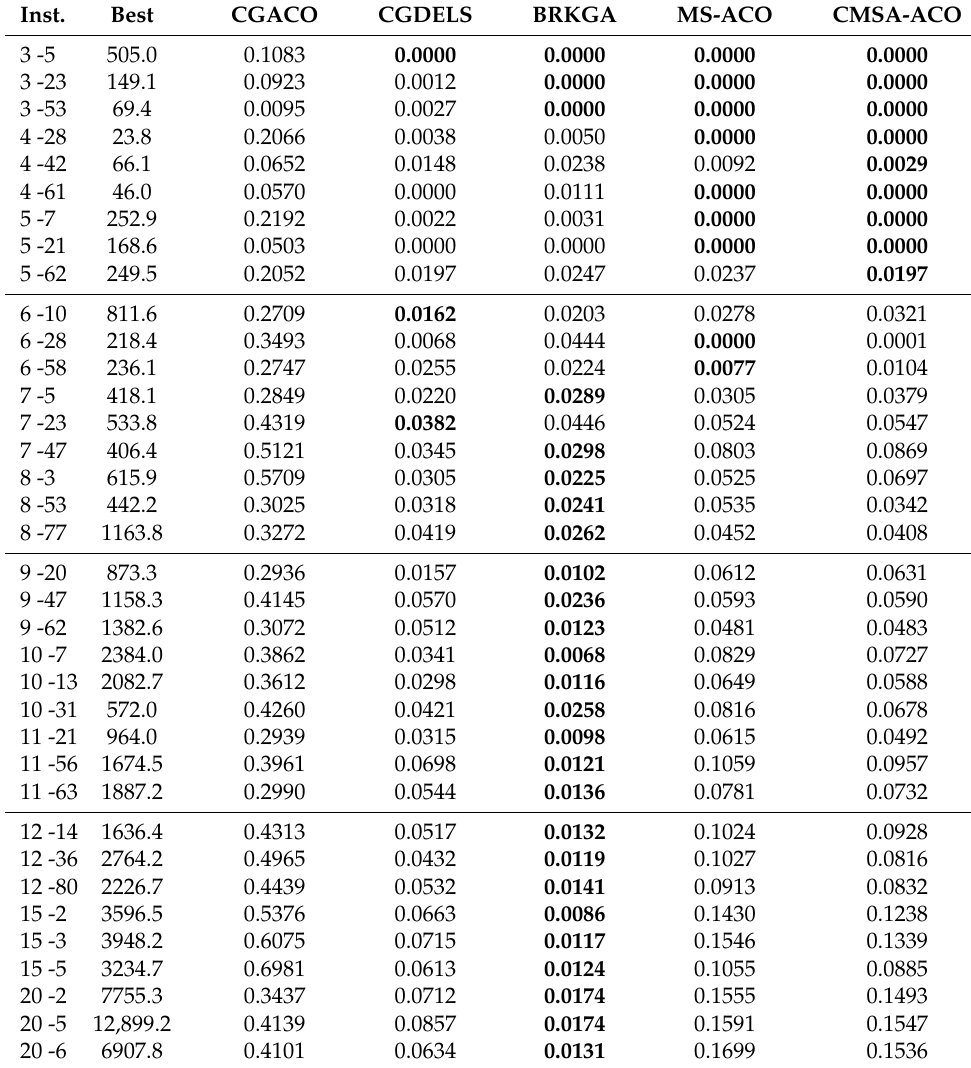
Table 3. A comparison of CGACO, CGDELS and BRKGA against MS and CMSA. The results are presented as the % difference from each method to the best known solution (column 2). The time limits for solving the restricted MIPs within MS-ACO and CMSA-ACO were set to 120 s. The best results are in bold. Statistically significant results, using a pairwise t -test, at the 95% confidence interval are